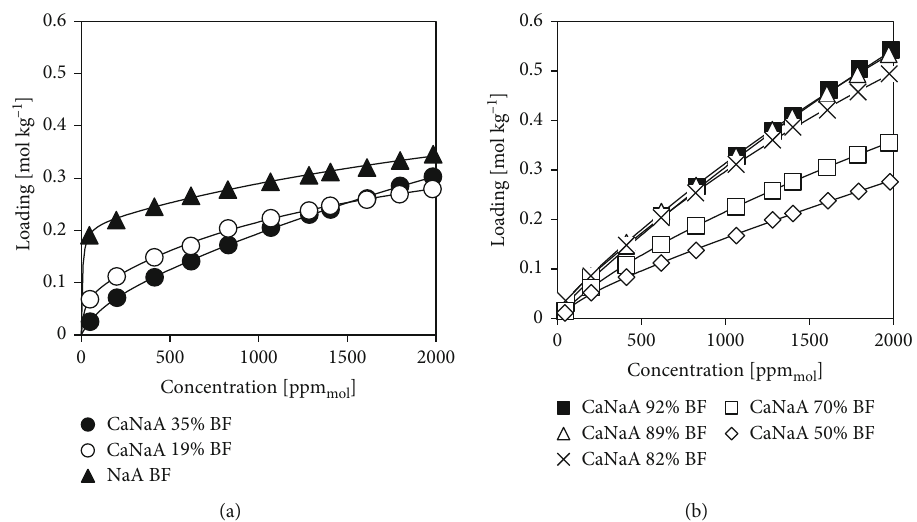
Figure 6: Division of H S isotherms at 85 ° C in (a) group 1 and (b) group 2 based on the shape. 2